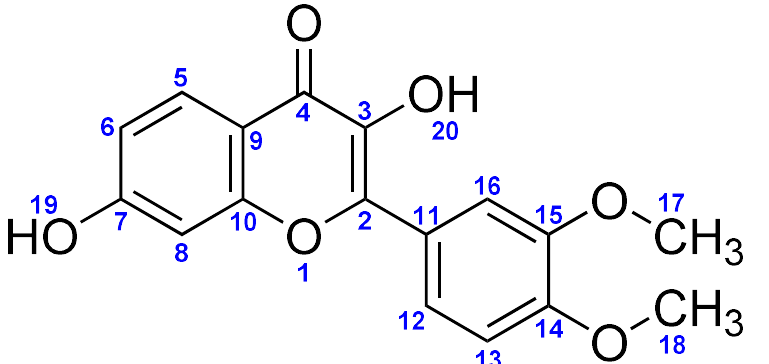
Figure 1. Structures of isolated 2-(3,4-dimethoxyphenyl)-3,7-dihydroxy-4H-chromen-4-one from Notholirion thomasonianum .